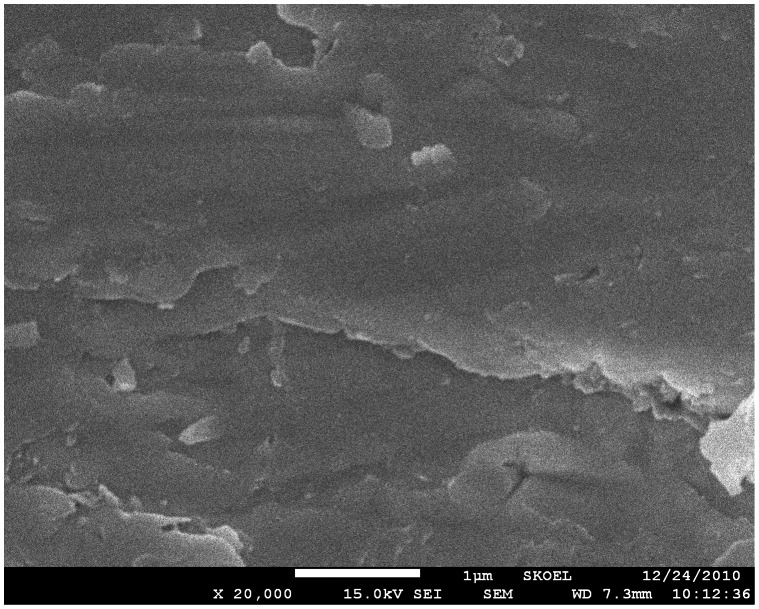
SEM image of the CSTO film formed in the electrolyte of EG +70%H2O +0.25%H3PO4+3.6%NH4F.